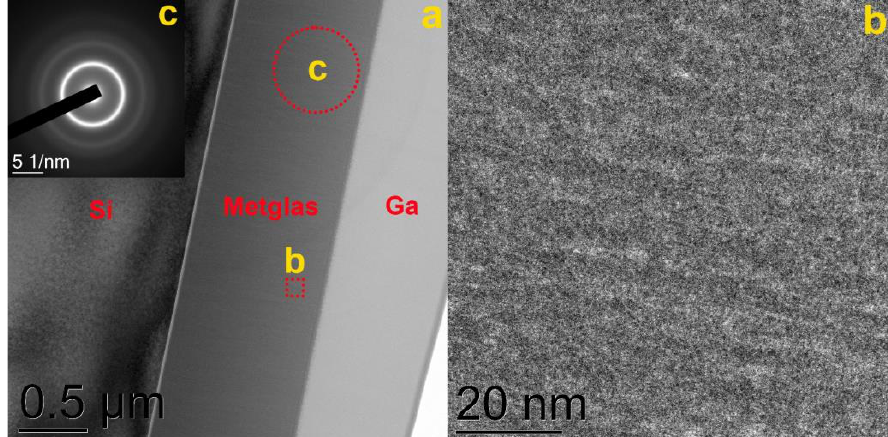
Figure 7. ( a ) TEM images of a metglas film produced at the third stage of the technology improve- ment comprising 5% oxygen; ( b ) enlarged lamella area; ( c ) SAED image with the specified SAED acquisition area.